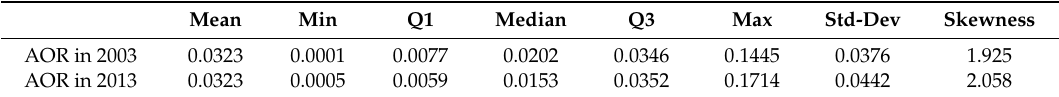
Table 1. Descriptive statistics of area occupation rate (AOR) of natural wetlands in 31 provinces in 2003 and